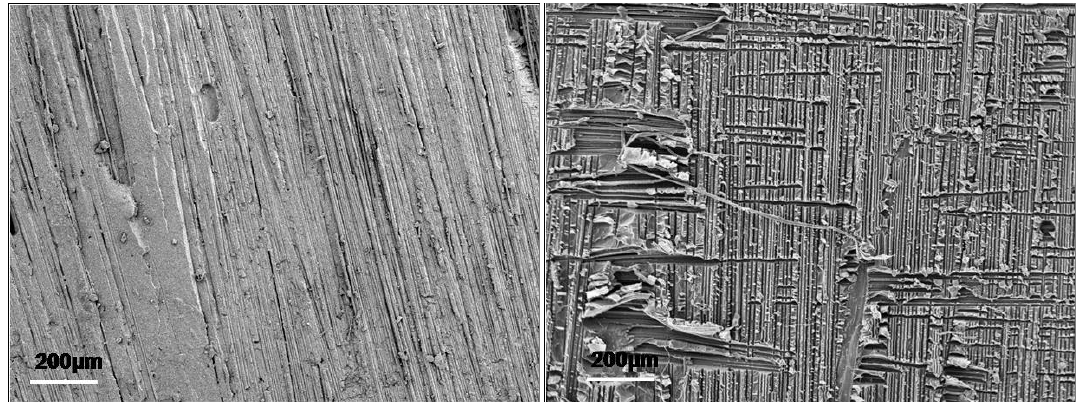
Figure 8. Fractography images of the reference sample ( left ) and sample reinforced with 2 wt % phenoxy ( right ) after end-notched flexure (ENF) test. (Note that only the 2% sample is shown for